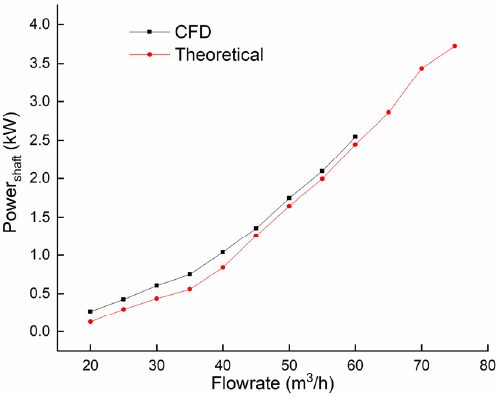
Figure 17. Power generated by the PAT.